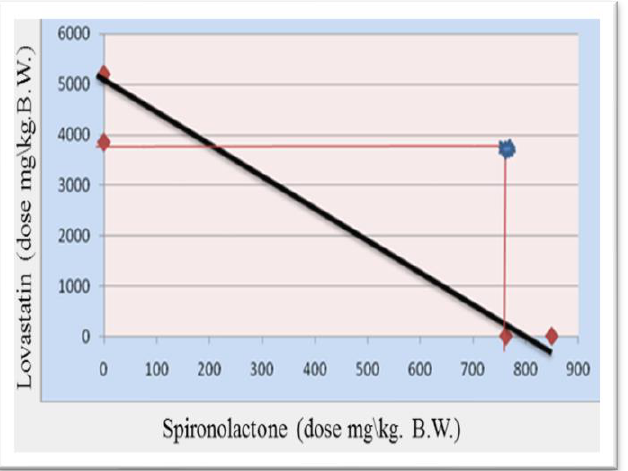
Figure 4. Isobolographic for chronic Toxicity interaction between spironolactone and lovastatin